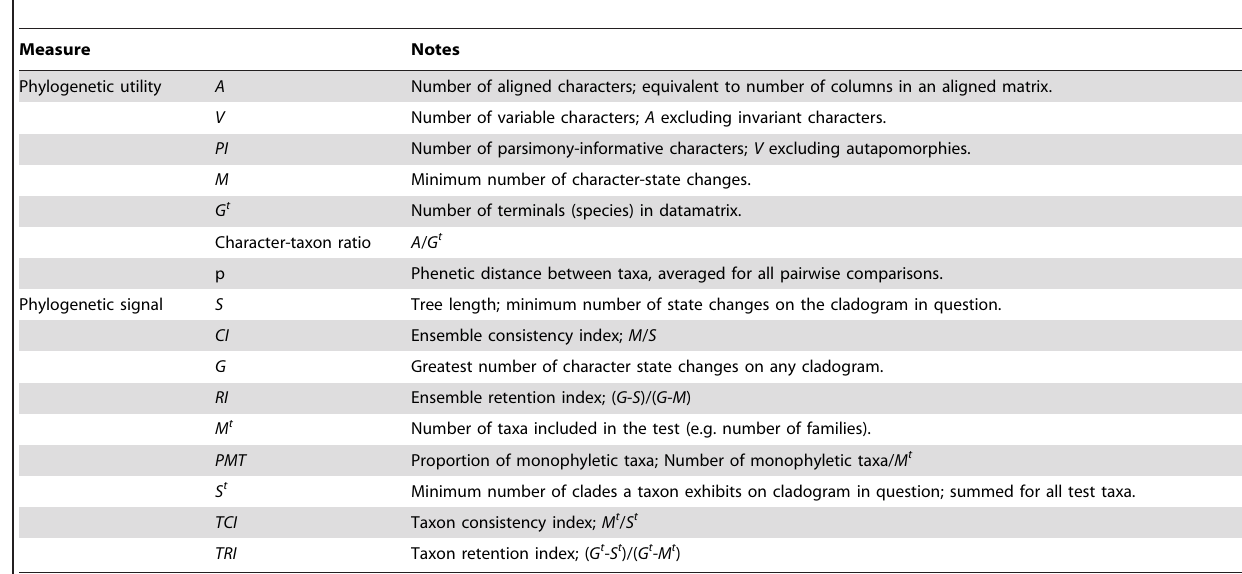
Table 1. Measures of phylogenetic utility and signal used in this